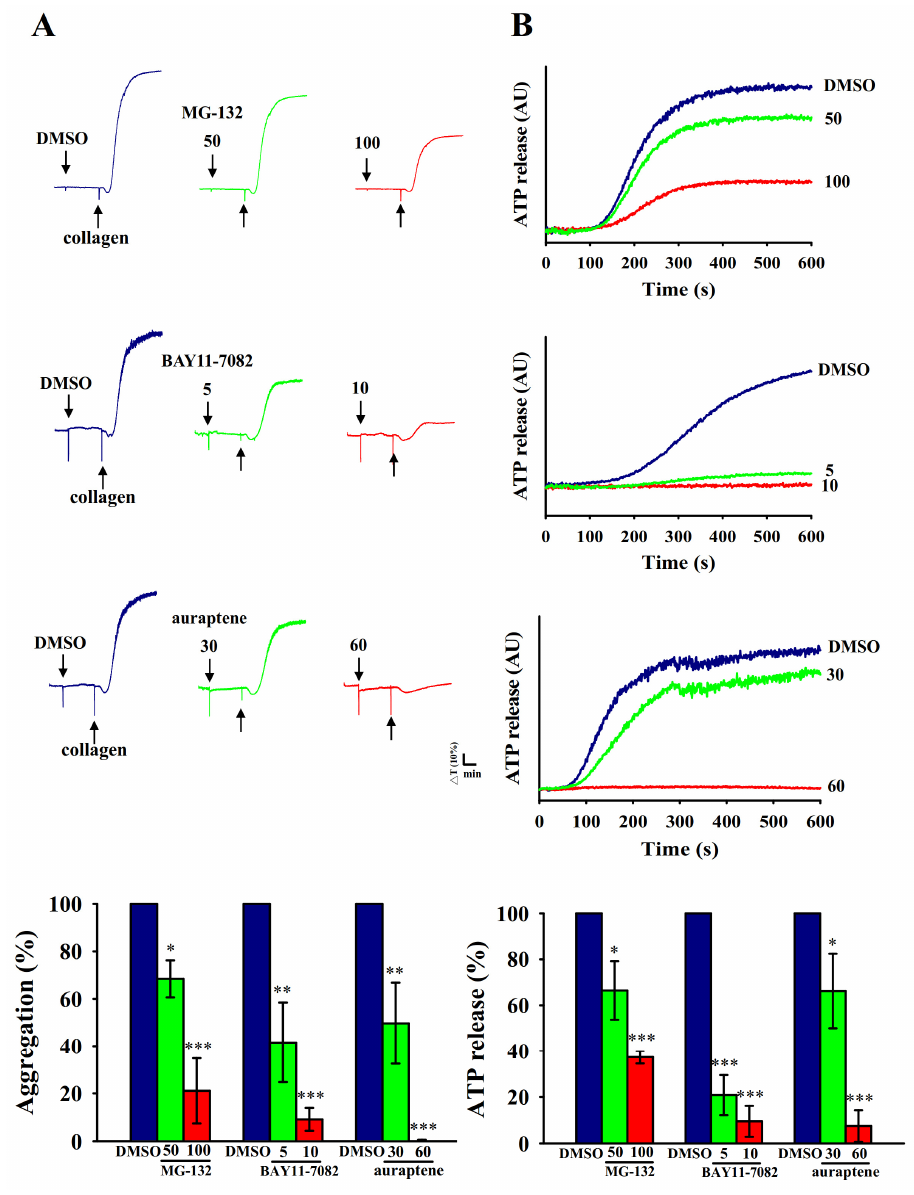
Figure 1. Inhibitory profiles of NF- κ B inhibitors and auraptene in platelet aggregation and ATP-release reaction stimulated by collagen in human platelets. Washed human platelets (3.6 × 10 8 cells / mL)